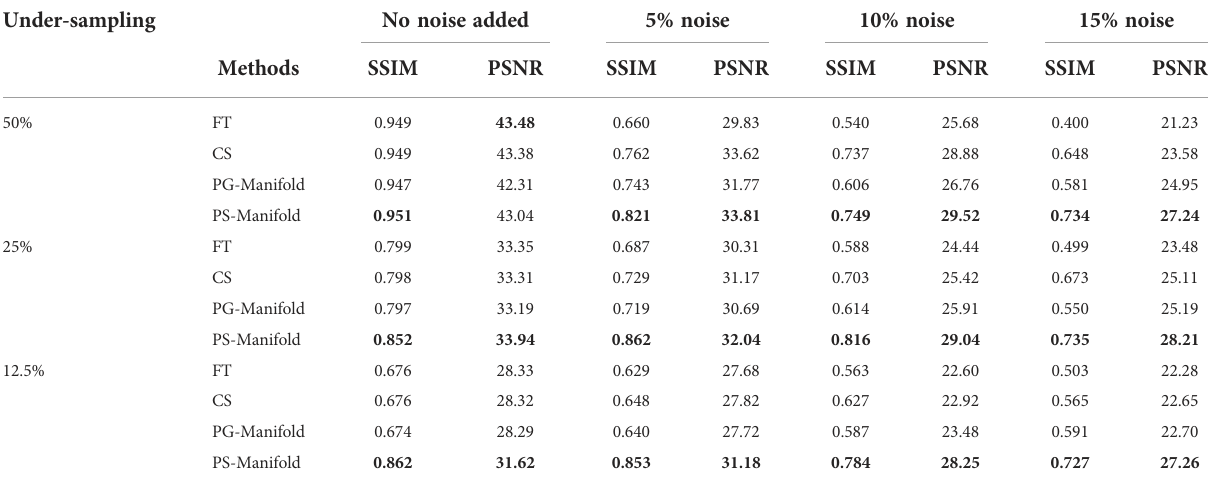
TABLE 2 Quantitative comparisons of FT, CS, patient-generic manifold, and patient-speci fi c manifold methods with different undersampling ratios and noise levels in the simulation case.